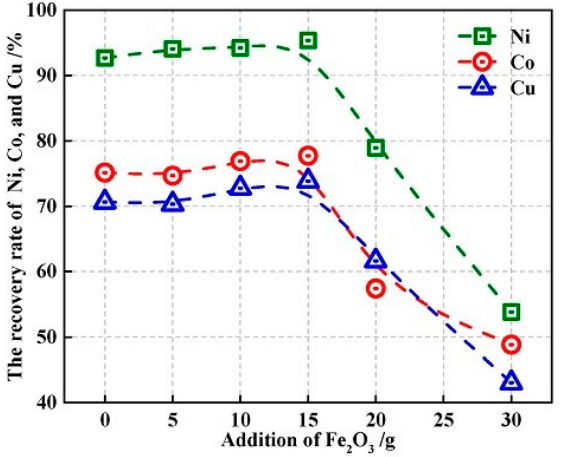
Figure 6. Addition of Fe 2 O 3 versus metals recovery rate.